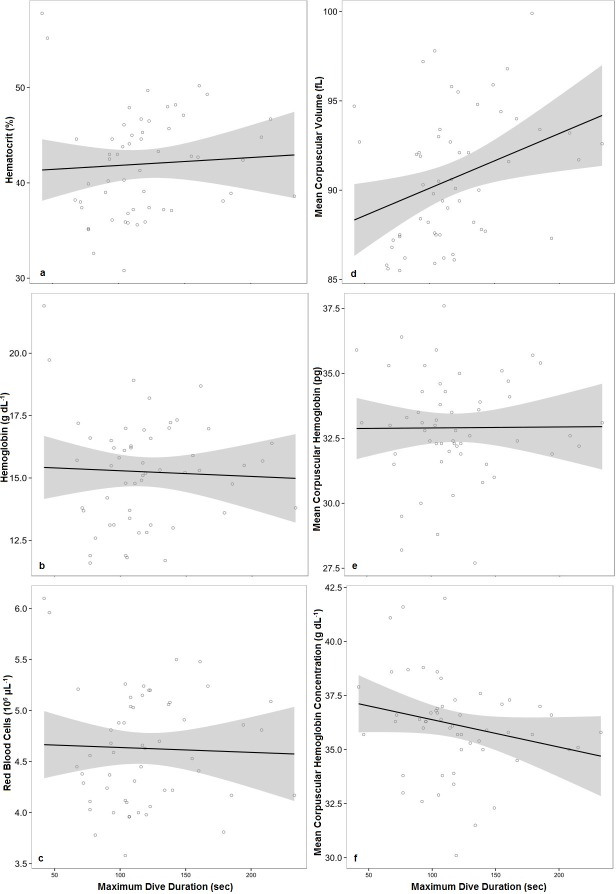
The Relationships Between Maximum Dive Duration and Standard Blood Measurements in Rehabilitating Harbor Seal Pups.Direct comparison between a behavioral diving parameter (maximum dive duration) and physiological parameters (Hct, Hb, RBC, MCV, MCH, MCHC). The black lines represent the lines of best fit, and the shaded areas represent the standard errors. Each individual data point corresponds to one measured instance from an individual.